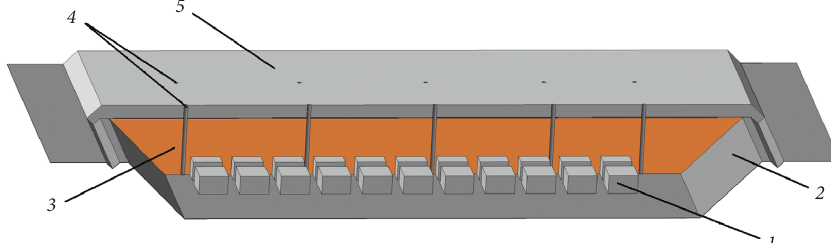
Figure 1: Appearance of the trench type storage: 1, containers with graphite waste; 2, compacted soil (clay); 3, clay-based safety barriers; 4, inspection tubes; 5, external protective screen (“cover”).